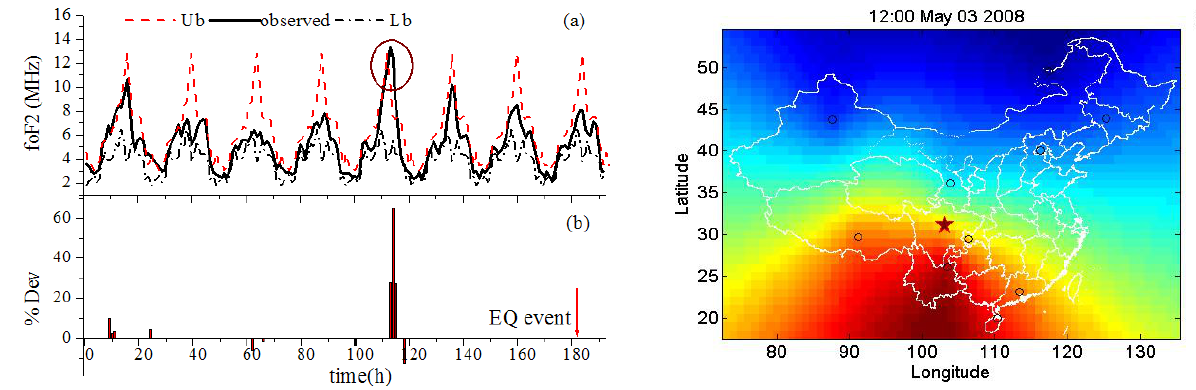
Fig. 2. foF2 ionospheric variation from 5 to 12 May, 2008 over Chongqing station. The observed foF2 variation and the corresponding upper- and lower- bounds are indicated, respectively, by full, dashed-point and dashed lines. The ellipse and the arrowhead indicate the obvious deviations time and the earthquake time occurrence.